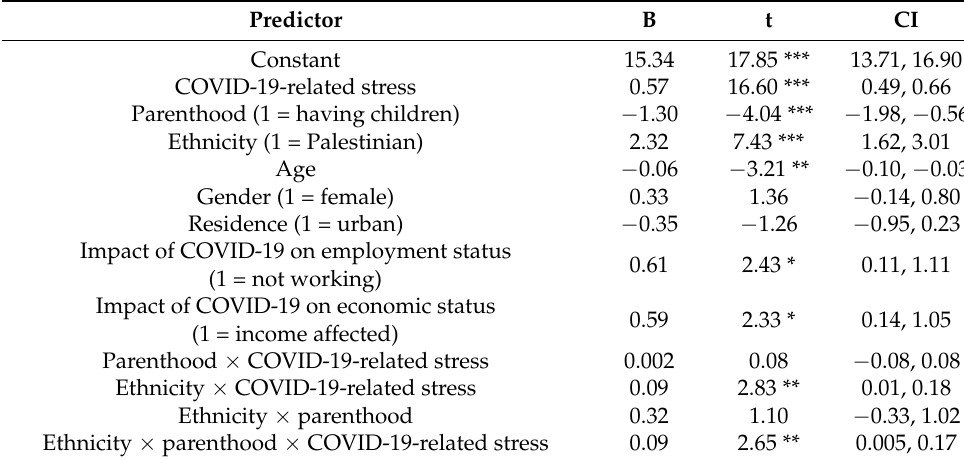
Table 2. Moderation